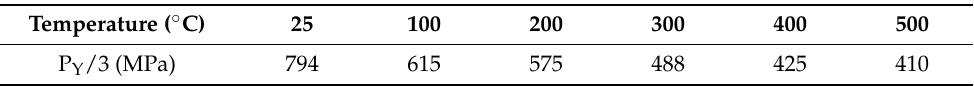
Figure 9. FIMEC curves obtained by indenting the W coating along the direction perpendicular to the surface at increasing temperatures up to 500 ◦ C ( a ). In the frame, the curves obtained in room temperature tests by indenting along perpendicular and parallel directions are compared. A long crack induced by parallel indentation is shown in ( b ) [52]. Table 1. P Y /3 values obtained from FIMEC tests at different